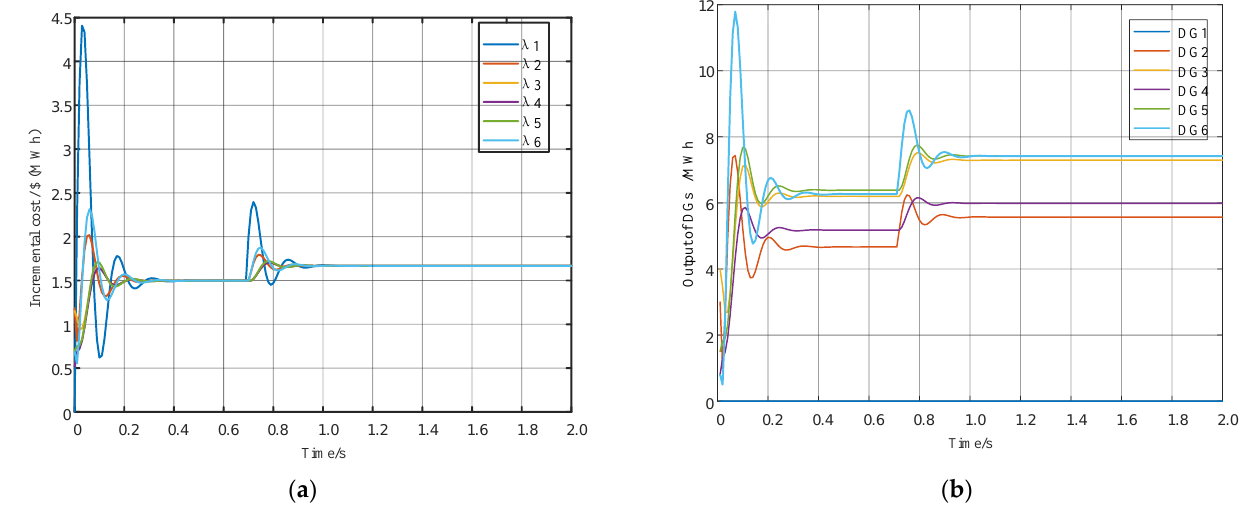
Figure 3. Incremental costs and DG outputs under ideal communication condition: ( a ) Incremental